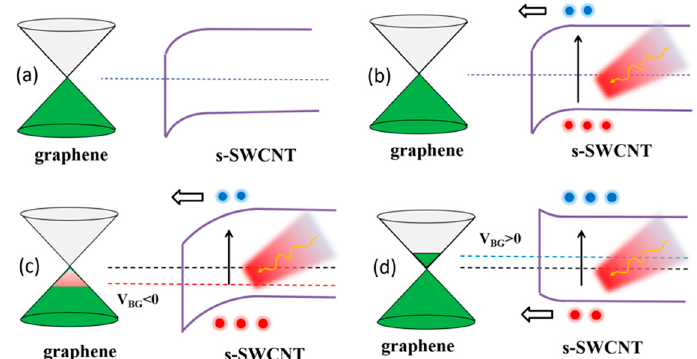
Figure 4. The energy level diagram at the graphene/s-SWCNT junction under different bias and illumination condition. ( a ) V SD = 0, V BG = 0, dark ( b ) V SD < 0, V BG = 0, light ( c ) V SD < 0, V BG < 0, light ( d ) V SD < 0, V BG > 0, light.